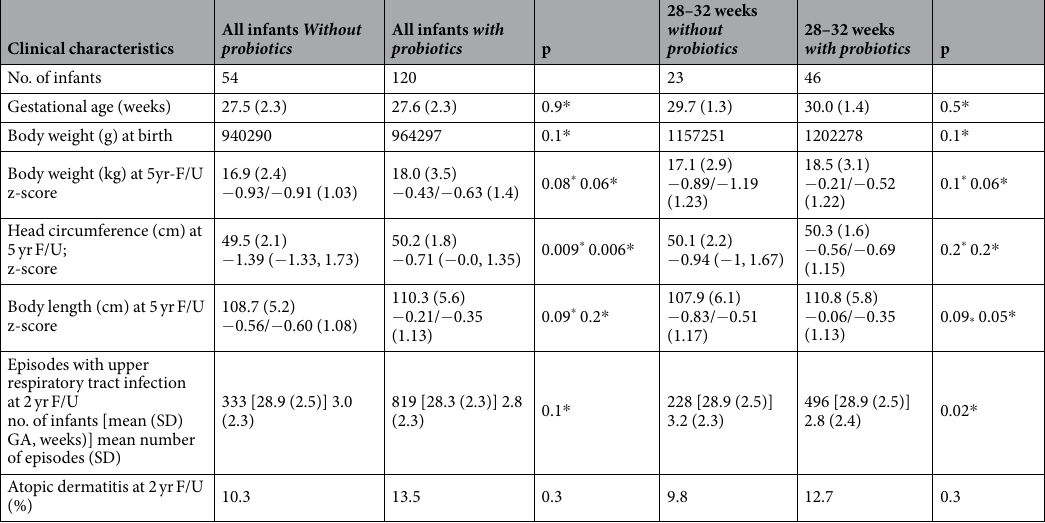
Table 3. Follow-up data according to prophylactic use of Lactobacillus acidophilus/Bifidobacterium infantis probiotics. Legend: Continuous variables are shown as mean (SD); z-scores are shown as mean/median (SD). Categorical variables are shown as percent. p-values were derived from Fisher’s exact test or Mann-Whitney-U test if indicated ( * ), SGA, small for gestational age ( < 10th percentile of birth weight adjusted to gestational age). Growth velocity and weight gain were calculated by differences between parameters at birth and respective measures at discharge/number of days (duration of